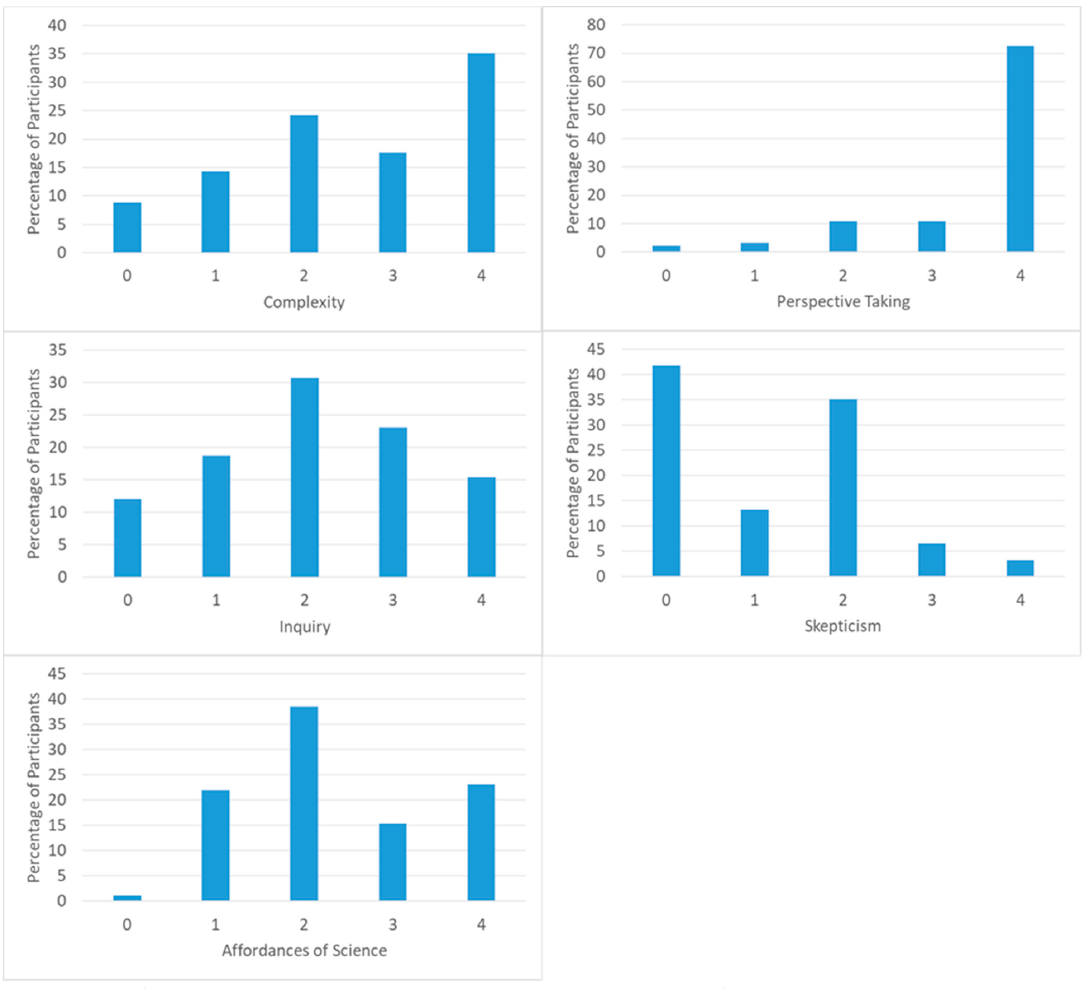
Figure 1. The frequency with which participants exhibited various levels of reasoning across SSR dimensions.